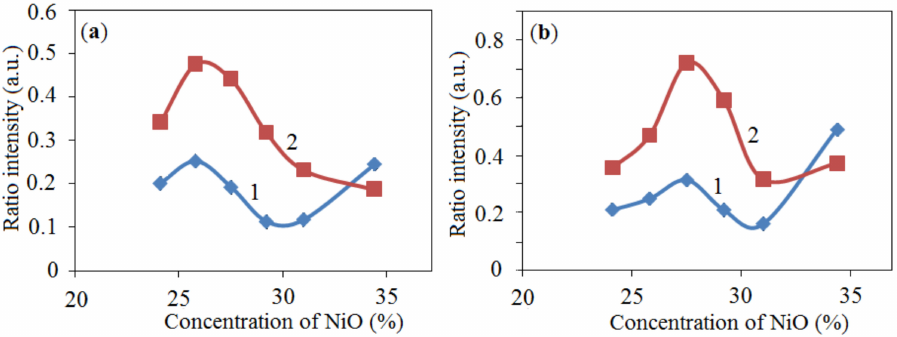
Figure 4. The influence of the NiO content in NiO–Al–Al 2 O 3 catalysts on the phase ratio: ( a ) 1—NiAl/Al, 2—NiAl/NiO; ( b ) 1—NiAl 2 O 4 /Al, 2—NiAl 2 O 4 /NiO.